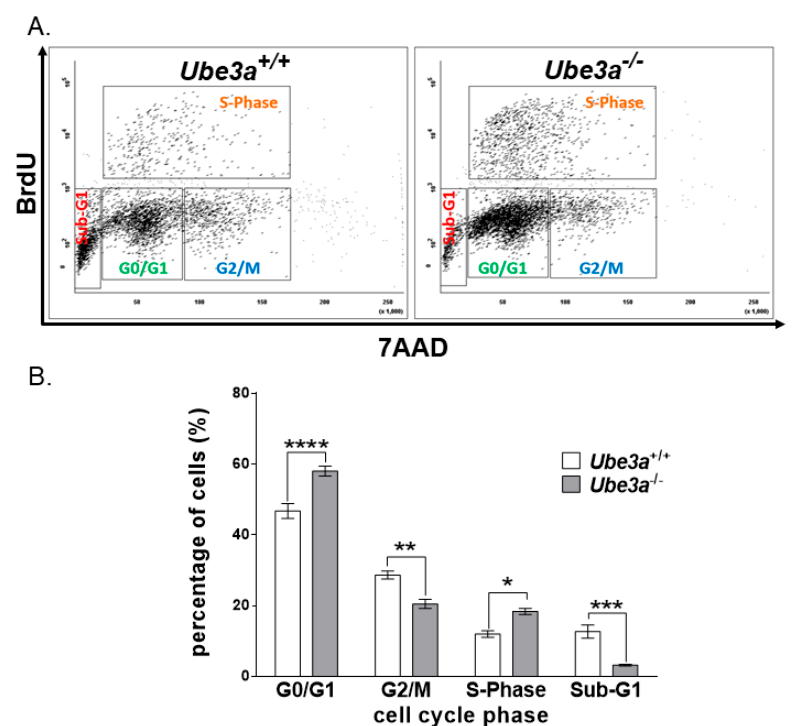
Figure 2. Ube3a deletion alters cell cycle progression. ( A ) Representative dual-parameter flow cytometry scatter plot showing the cell cycle progression of BrdU versus 7AAD, following 1-h incubation with BrdU in Ube3a +/+ and Ube3a − / − MEFs. ( B ) Graph showing the respective percentages of cells at